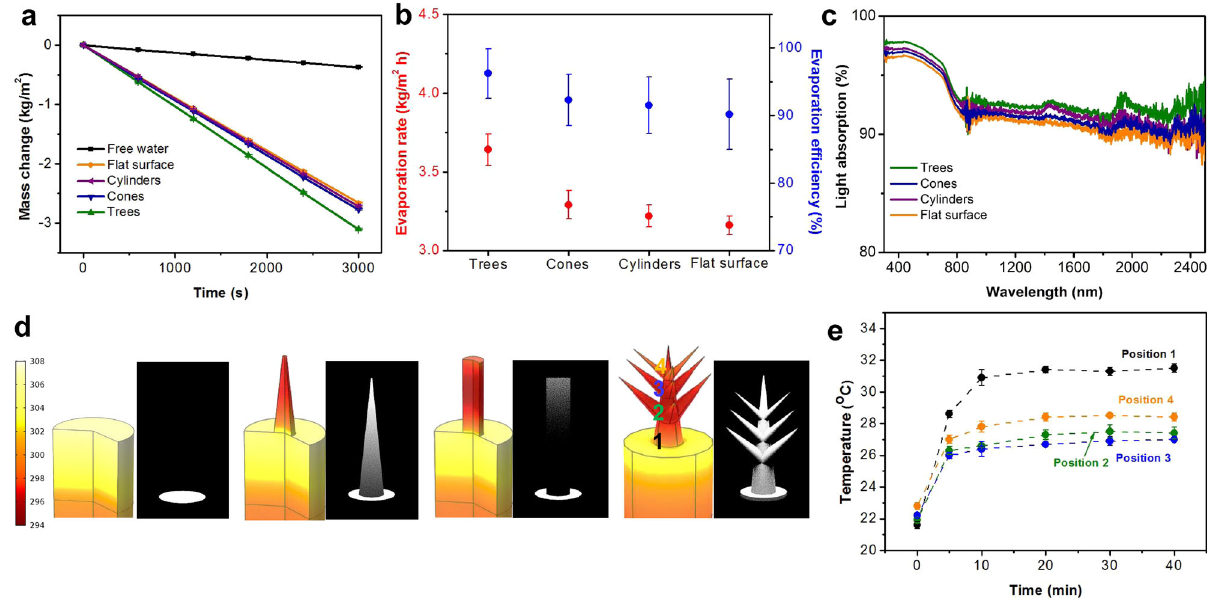
Fig. 4 Solar steam generation properties of microstructured PVA/PPy gel membranes. a Water loss for different membrane shapes under 1 sun, with free water as control. b Evaporation rate and energy ef fi ciency for different tested micro-topologies. c Light absorption spectra over wavelengths of 250 – 2500 nm of gel membranes with different micro-topologies. The small jump of the curves at wavelength ~900 nm is caused by the switch of detectors. d Surface temperature contours (left) and illuminated pattern (right) for different micro-topologies under normal 1 sun illumination, simulated using COMSOL. e Measured surface temperature as a function of time at four positions along the height of a typical gel